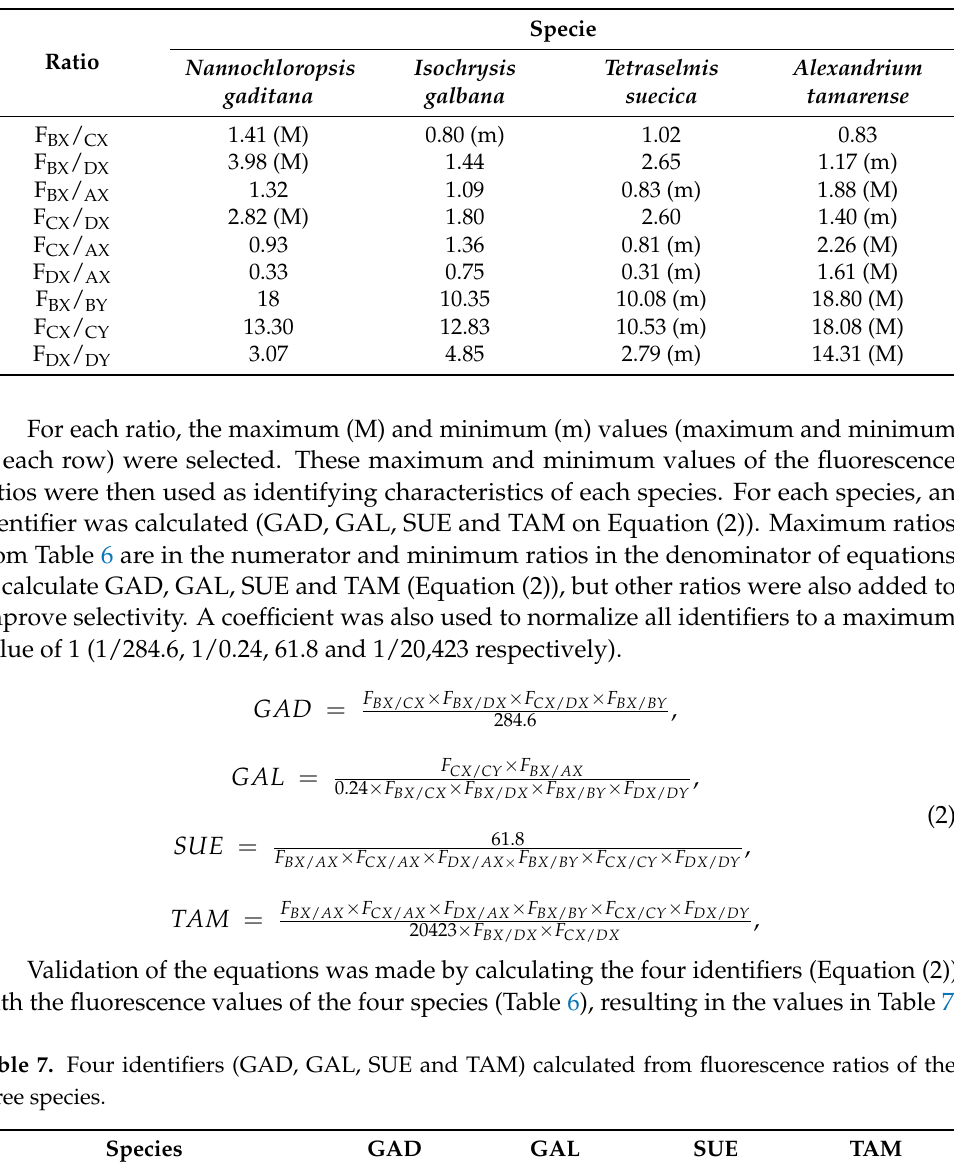
Table 6. Fluorescence ratios used to distinguish Nannochloropsis gaditana, Isochrysis galbana Tetraselmis suecica and Alexandrium tamarense.